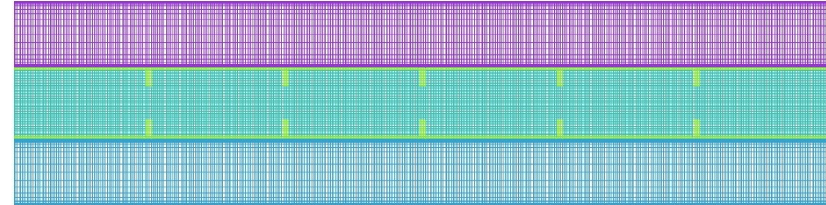
Figure 4. The configuration of the mesh after grid independence analysis (using 43,000 cells).